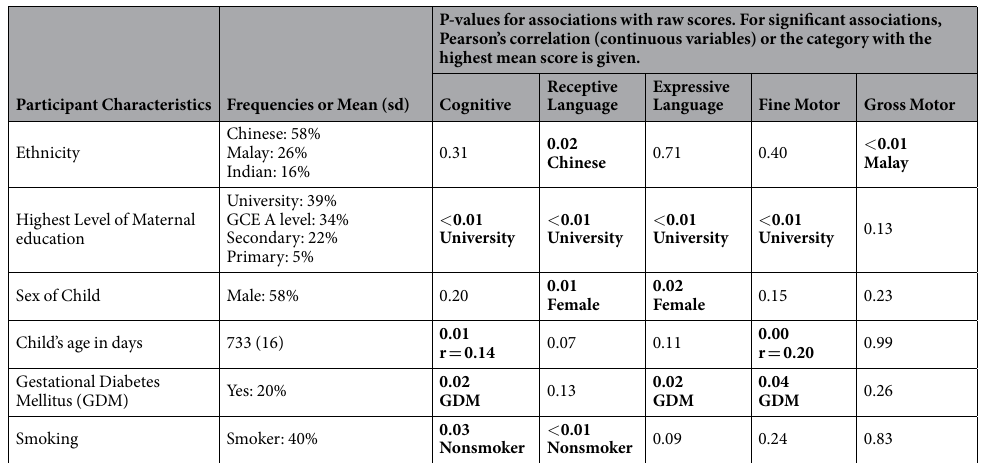
Table 1. Participant charateristics significantly associated with at least one raw BSID-III score. Association p-values are based on Welch’s t-test for dichotomous variables, ANOVA for categorical or ordinal variables with more than two categories, and tests of correlation for continuous variables. Values less than 0.05 are shown in bold. For significant associations, Pearson’s correlation (continuous variables) or the category with the highest mean score is